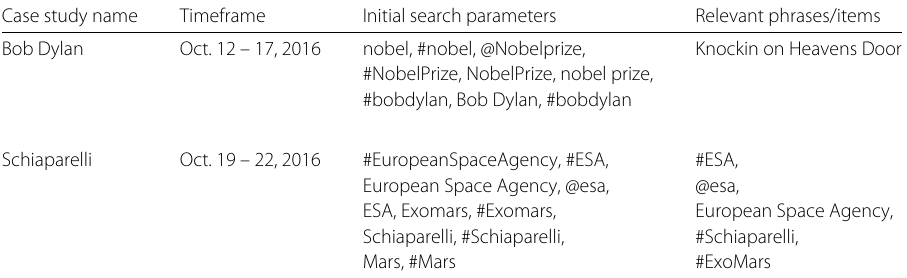
Table 1 Timeframes, initial search parameters, and relevant phrases/items for subgraph extraction used in the case